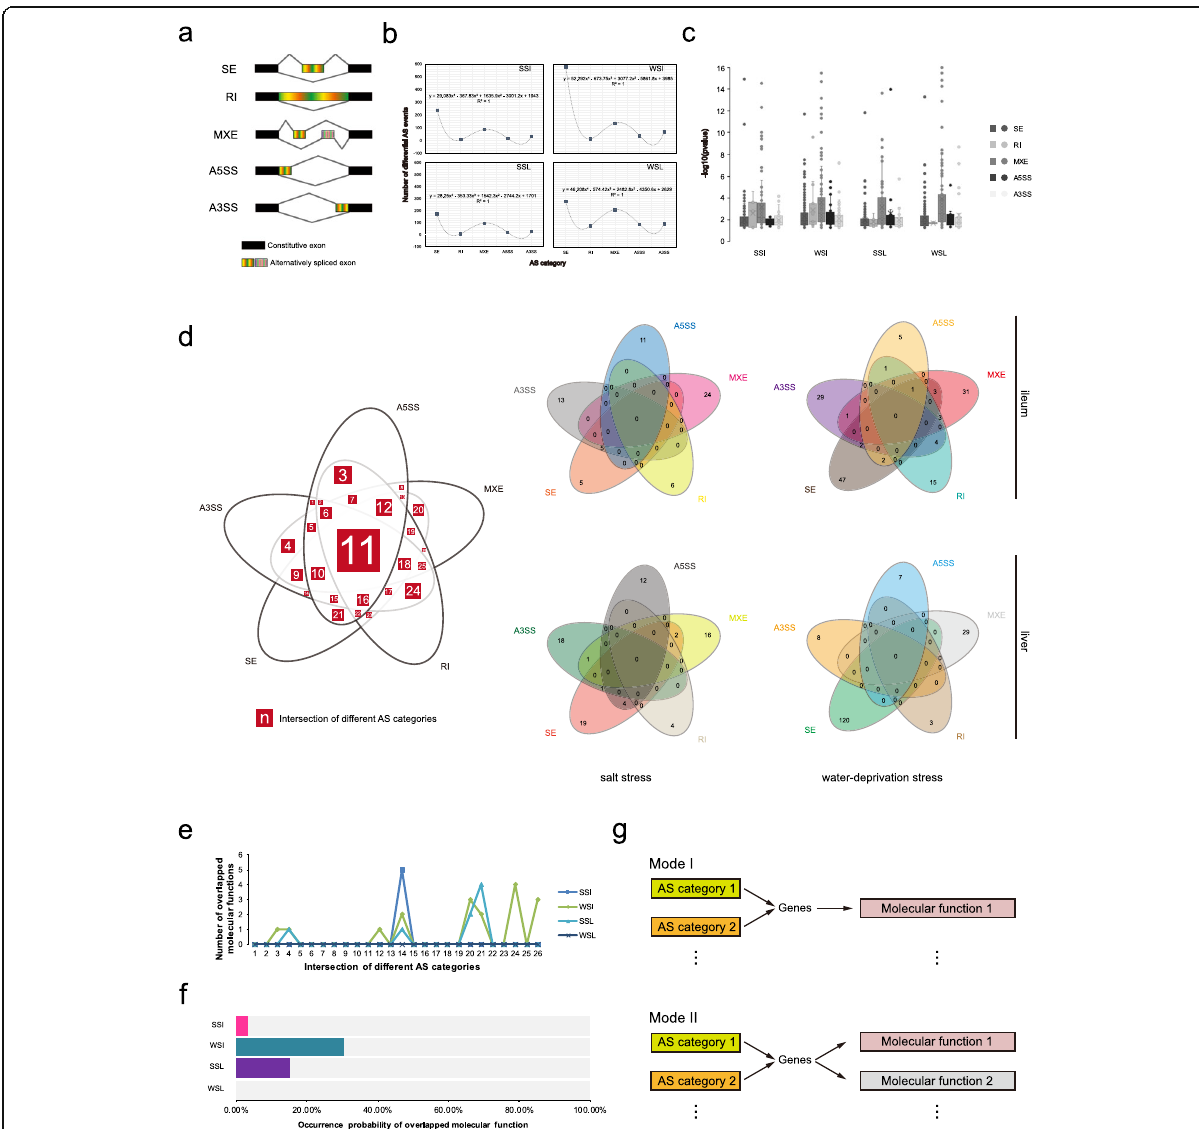
Fig. 1 Alternative splicing events in the ileum and liver of camel under salt stress and water-deprivation stress. a Five categories of alternative splicing. b Number of differential AS events in the five AS categories of SSI, WSI, SSL and WSL. c Distribution of -log10 ( p value) values of differential AS events in each AS category. d Number of molecular functions enriched by protein-coding genes involving differential AS events. e Number of overlapped molecular functions on intersections of different AS categories. f Incidence of enriched similar molecular function from genes regulated by different AS categories. g Two tendentious modes. AS means alternative splicing. A3SS, A5SS, MXE, RI and SE refer respectively to alternative 3 ′ splice site, alternative 5 ′ splice site, mutually exclusive exons, retained intron and skipped exon. SSI, WSI, SSL, and WSL separately indicate ileum under salt stress, ileum under water-deprivation stress, liver under salt stress and liver under water-deprivation